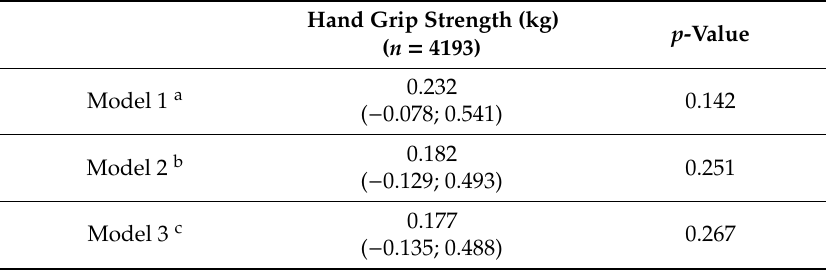
Table 3. Longitudinal associations between Ferric Reducing Ability of Plasma (FRAP) score and hand grip strength.